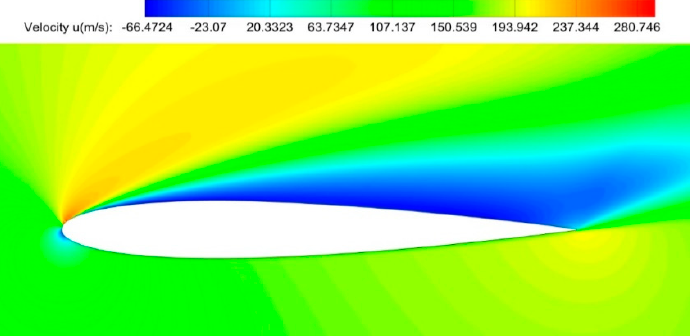
Figure 24. t = 0.15 s, velocity distribution of standard NACA0012 airfoil at a 14° angle of attack.